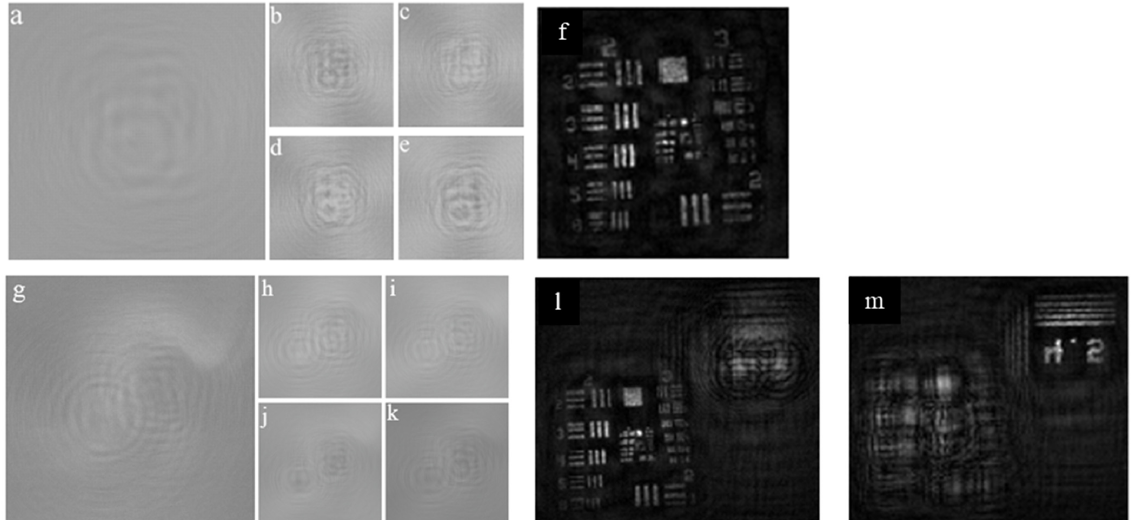
Figure 8. ( a ) Image of the single-shot raw hologram of a single-plane object and ( b – e ) four phase-shifted holograms 0, π /4, π /2 and 3 π /4, respectively. ( f ) Reconstruction result of a USAF1951 resolution target. ( g ) Image of the single-shot raw hologram of a two-planes object consisting of a USAF1951 object and NBS object separated by a distance of 65 mm, ( h – k ) four phase-shifted holograms 0, π /4, π /2 and 3 π /4, respectively. Reconstruction result by numerical propagation to the plane of ( l ) USAF and ( m ) NBS. (Adapted from [35].)